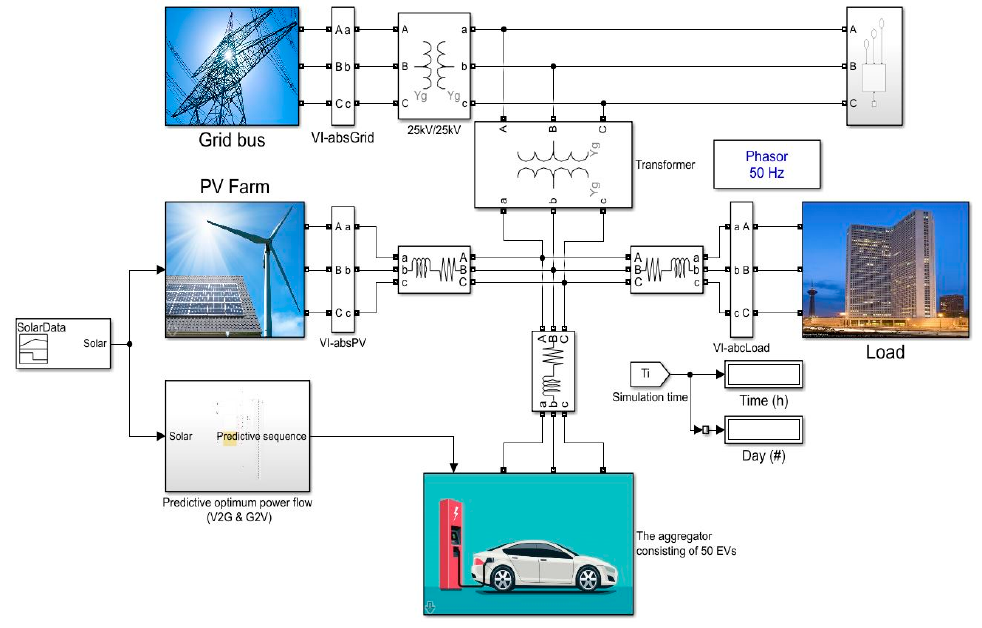
Figure 7. Virtual nano-grid architecture.